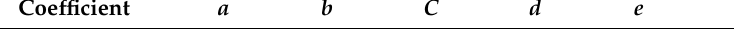
Table 5. Estimated values of coefficients in the vulnerability model.